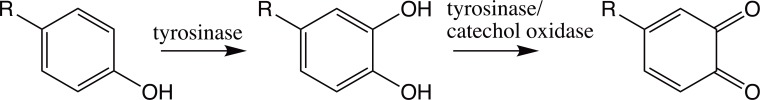
Tyrosinase and catechol oxidase activity.